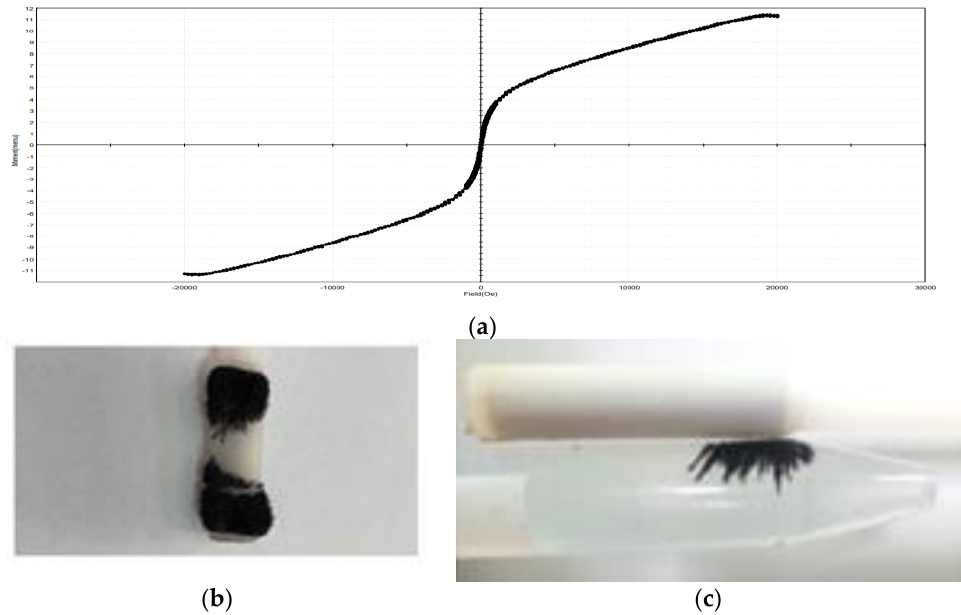
Figure 5. Photographs of ( a ) magnetization curve of the magnetic LCF sample obtained by VSM, ( b ) LCF powder loaded on magnetic bar, and ( c ) LCF powder in water collected with eternal magnetic bar.